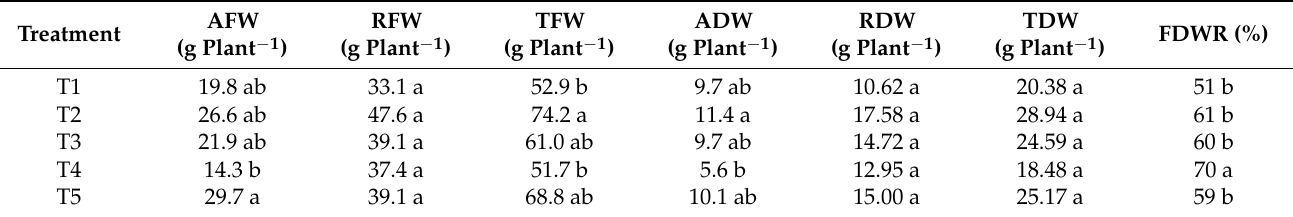
Table 4. Allocation of fresh and dry weight to the aerial and epigeal parts of raspberry plants cv Himbo Top grown on substrates with various ratios of peat and compost obtained from solid digestate and pruning woods. Means followed by the same letter do not significantly differ at p -value < 0.05. T1, Commercial Peat (P) 90% + Compost A (CA) 10%; T2, P 80% + CA 20%; T3, P 60% + CA 40%; T4, Commercial Peat (P) 100%; T5, P 100% + Osmocote. AFW, fresh weight of the aerial part of the